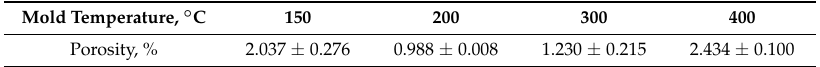
Table 1. Porosities of the composites thixoformed under different mold